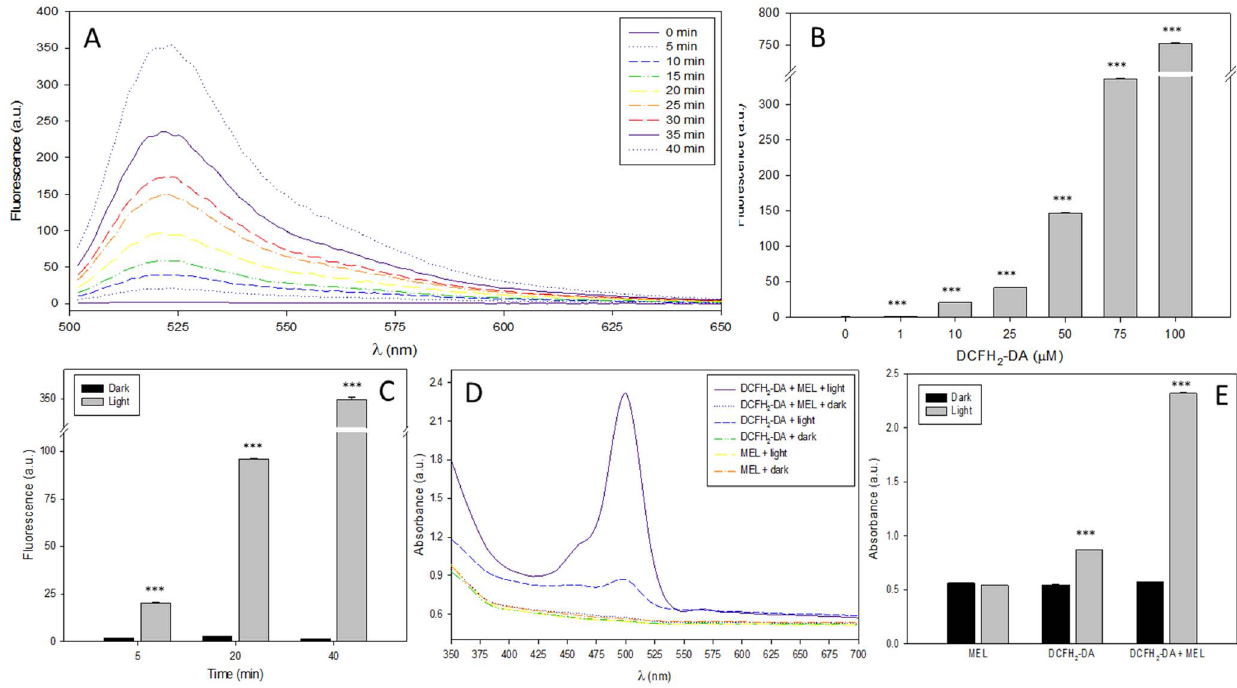
Figure 1. Effect of melatonin on light-induced DCFH 2 -DA oxidation. A) Fluorescence spectrum ( l exc =485 nm, l em =500–700 nm) of DCFH 2 - DA (100 m M) plus MEL (1 mM) under light (0–40 min). B) Fluorescence of several concentrations of DCFH 2 -DA plus MEL (1 mM) and light 60 minutes. ***p , 0.001 vs no treat. C) Fluorescence of DCFH 2 -DA plus MEL (1 mM) during 5, 20 or 40 minutes under light or dark conditions. ***p , 0.001 vs Darkness. D) Absorbance Spectrum (350–700 nm) of DCFH 2 -DA (100 m M) or MEL (1 mM) alone or mixed under 30 minutes of dark or light conditions. E) Absorbance measurement at 505 nm of MEL (1 mM), DCFH 2 -DA (100 m M), alone or mixed under 30 minutes of light or dark conditions. ***p , 0.001 vs